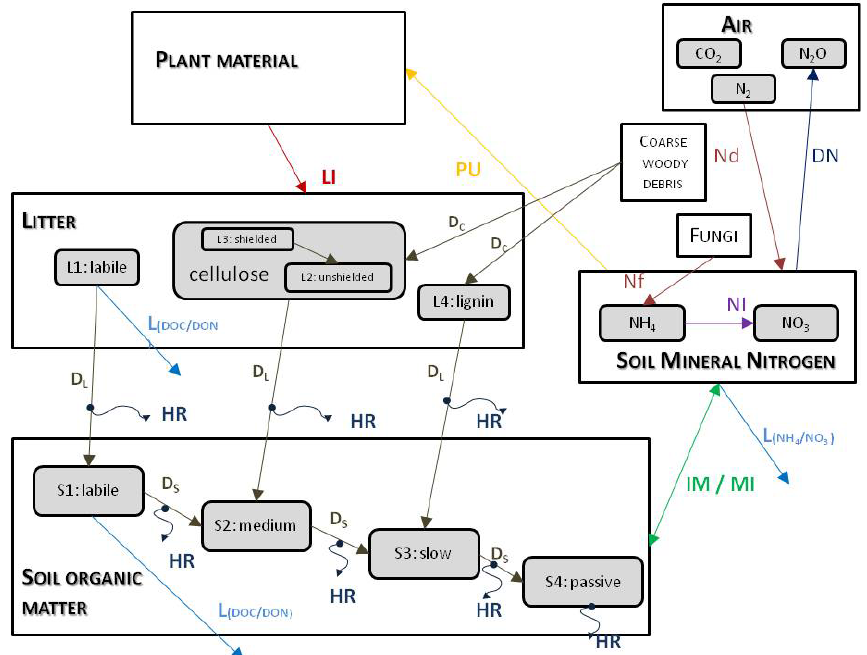
Figure 3. Soil- and litter-related simulated carbon and nitrogen fluxes (arrows) as well as pools (rectangles) in Biome-BGCMuSo v6.2. HR: heterotrophic respiration, IM: immobilization, MI: mineralization, PU: plant uptake, LI: litterfall, NI: nitrification, D : decomposition ( D L : decomposition of litter, D S : decomposition of SOM, D C : fragmentation of coarse woody debris), L : leaching, Nf: nitrogen fixation, Nd: nitrogen deposition, DN: denitrification. L represents loss of C and N from the simulated